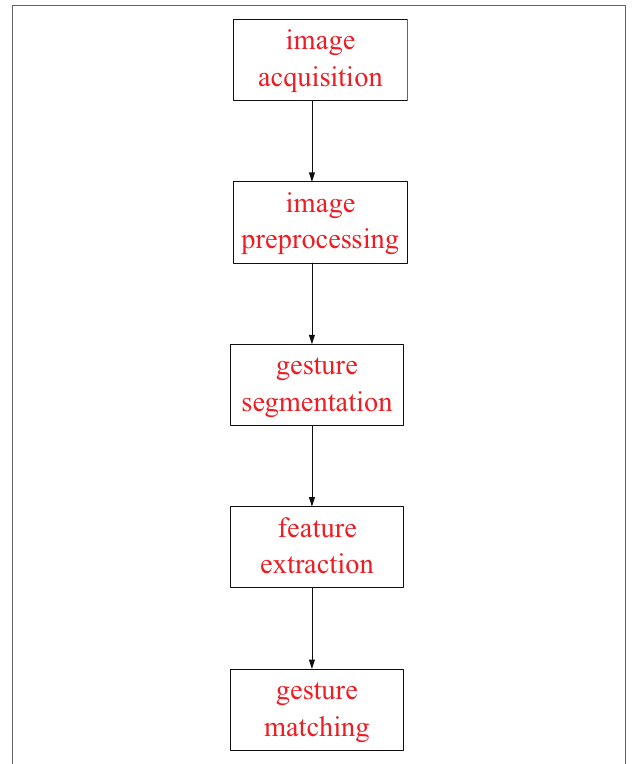
FIGURE 1 | Action recognition